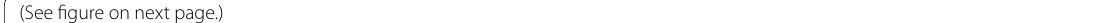
figure on next Fig. 3 Shallow tremors observed using the OBSs during the observation period showing the a epicenter distribution of all shallow tremors obtained in this study (red circles) and all OBS stations used for the observation period (blue squares). Other contours and symbols are the same as those in Fig. 1. b Spatiotemporal plot projected on the W–E line shown in a . based on JST time (UTC three major earthquakes that affected the shallow tremor activity. The shallow tremor activity is divided into Episodes (ep.) 1–6 according to the characteristics of the